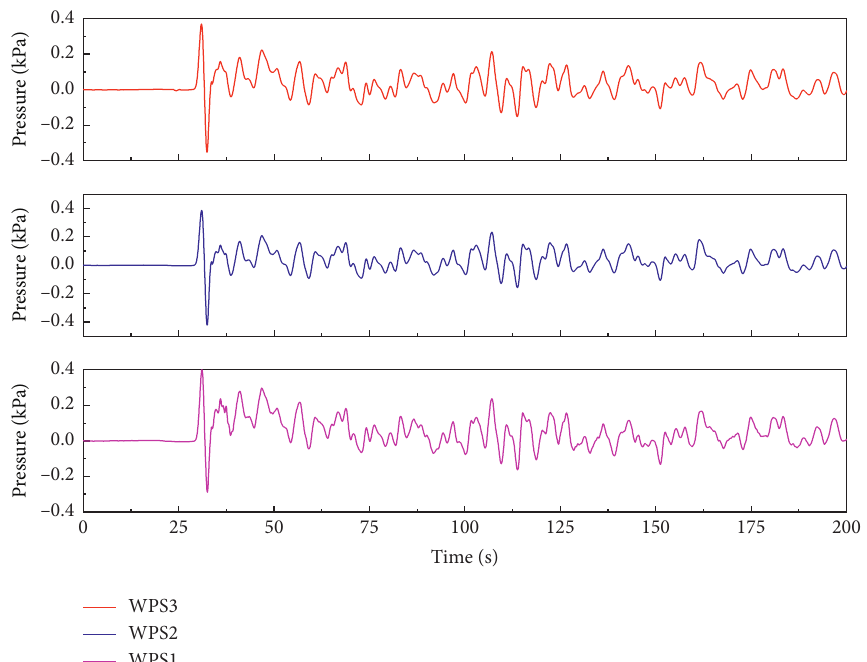
Figure 8: The dynamic pressure processes from test no. 81, with l � 1.0m, w � 1.5m, s � 0.6m, h � 1.16m, and α � 60 °